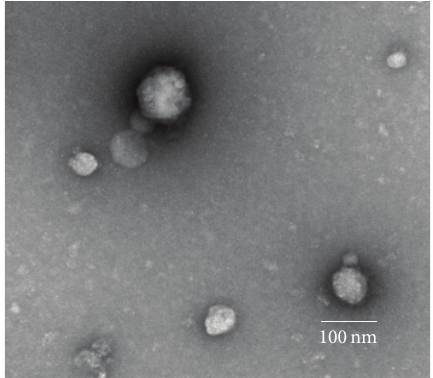
Figure1:Transmissionelectronmicrographofasampleofthepellet obtained by ultracentrifugation of Coon’s Modified Ham’s F-12, 6- hormone medium used to grow FRTL-5 cells. Objects in the frame exhibit the characteristic shape of microvesicles under transmission electron microscopy, a spherical shape between 30 and 100 nm in diameter.